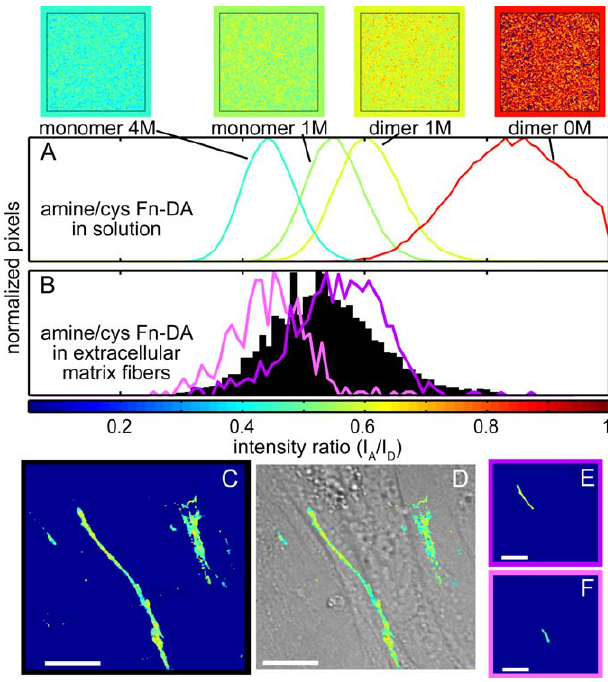
Figure 3. Fn Conformation in Matrix Fibrils Spatial ratiometric images and histograms of all pixels within each field of view are shown for dimeric amine/cys Fn-DA in 0 and 1 M GdnHCl and monomeric amine/cys Fn-DA in 1 and 4 M GdnHCl (A). Amine/cys Fn-DA was added to the culture medium of fibroblasts for 24 h, and excess Fn-u was added to suppress intermolecular energy transfer. Confocal micro- scopic images of acceptor and donor peak intensities taken 1 l m above the glass–cell interface were background subtracted, averaged, and thresholded, and the I A / I D ratiometric image of acceptor to donor was color-coded within the range of 0.05 to 1.0. A histogram (B) for all pixels of amine/cys Fn-DA–containing ECM (C) and an overlay of I A / I D on the DIC image (D) are shown in a region in which the matrix showed a transition from low to intermediate I A / I D within a single Fn fiber. Histograms are overlaid in (B) for regions of extended (E; purple) and unfolded Fn (F; pink). Histograms were generated with 0.01-ratio-unit